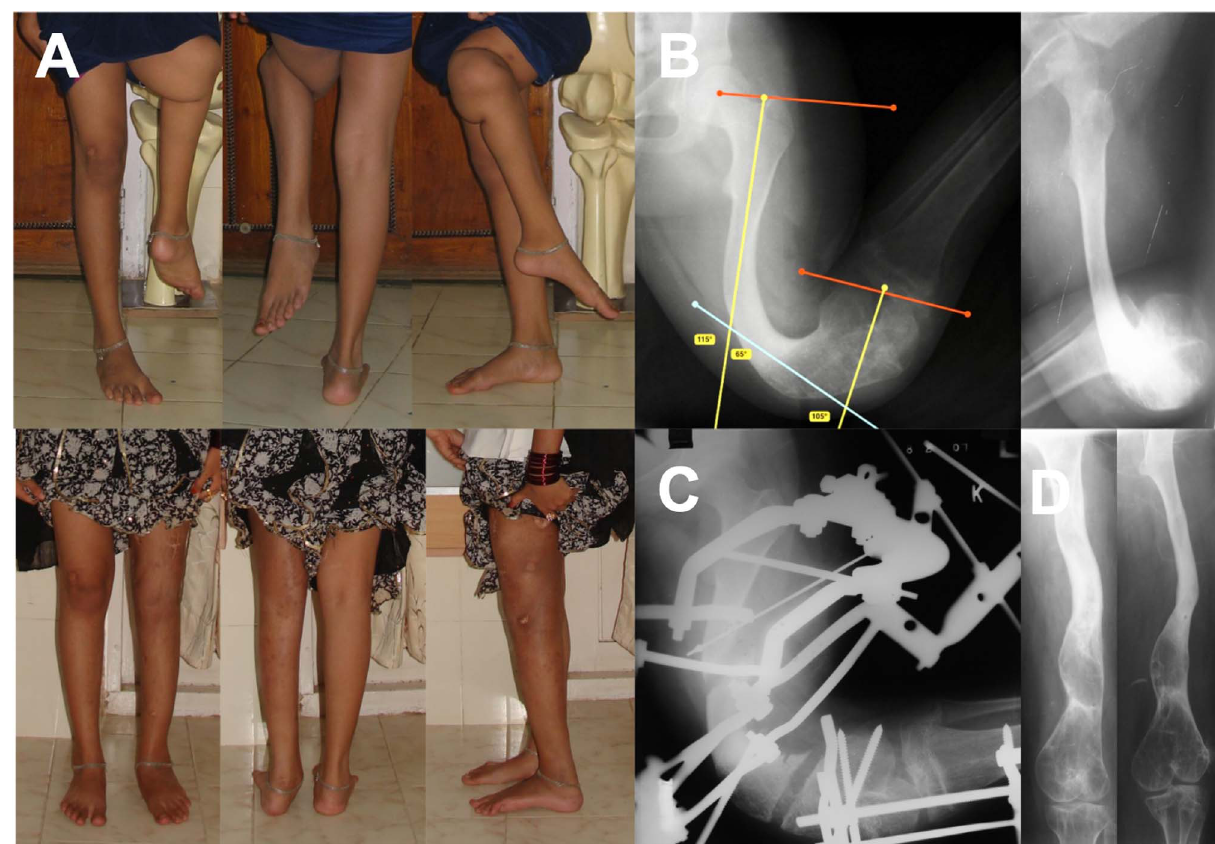
Figure 2. Severe femoral deformity . Clinical before and after images of a girl with a large complex femoral deformity (A). Preoperative planning (B) and meticulous execution with a hinged Ilizarov frame manipulating the double femoral osteotomy (C) resulted in an excellent clinical result (A and